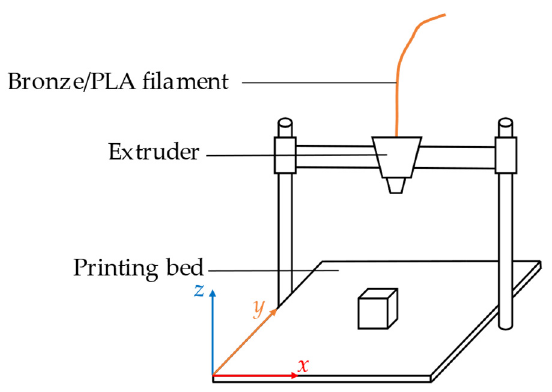
Figure 2. Printing direction of cubes with edge length 10 mm.